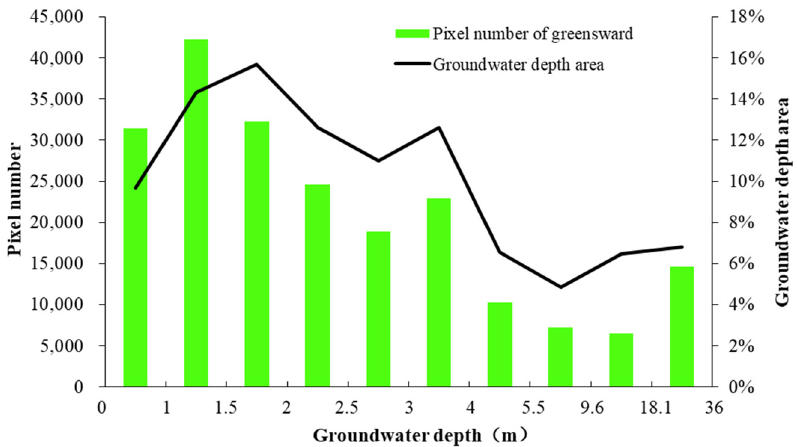
Figure 9. Distribution area of groundwater depth and the number of greensward pixels.